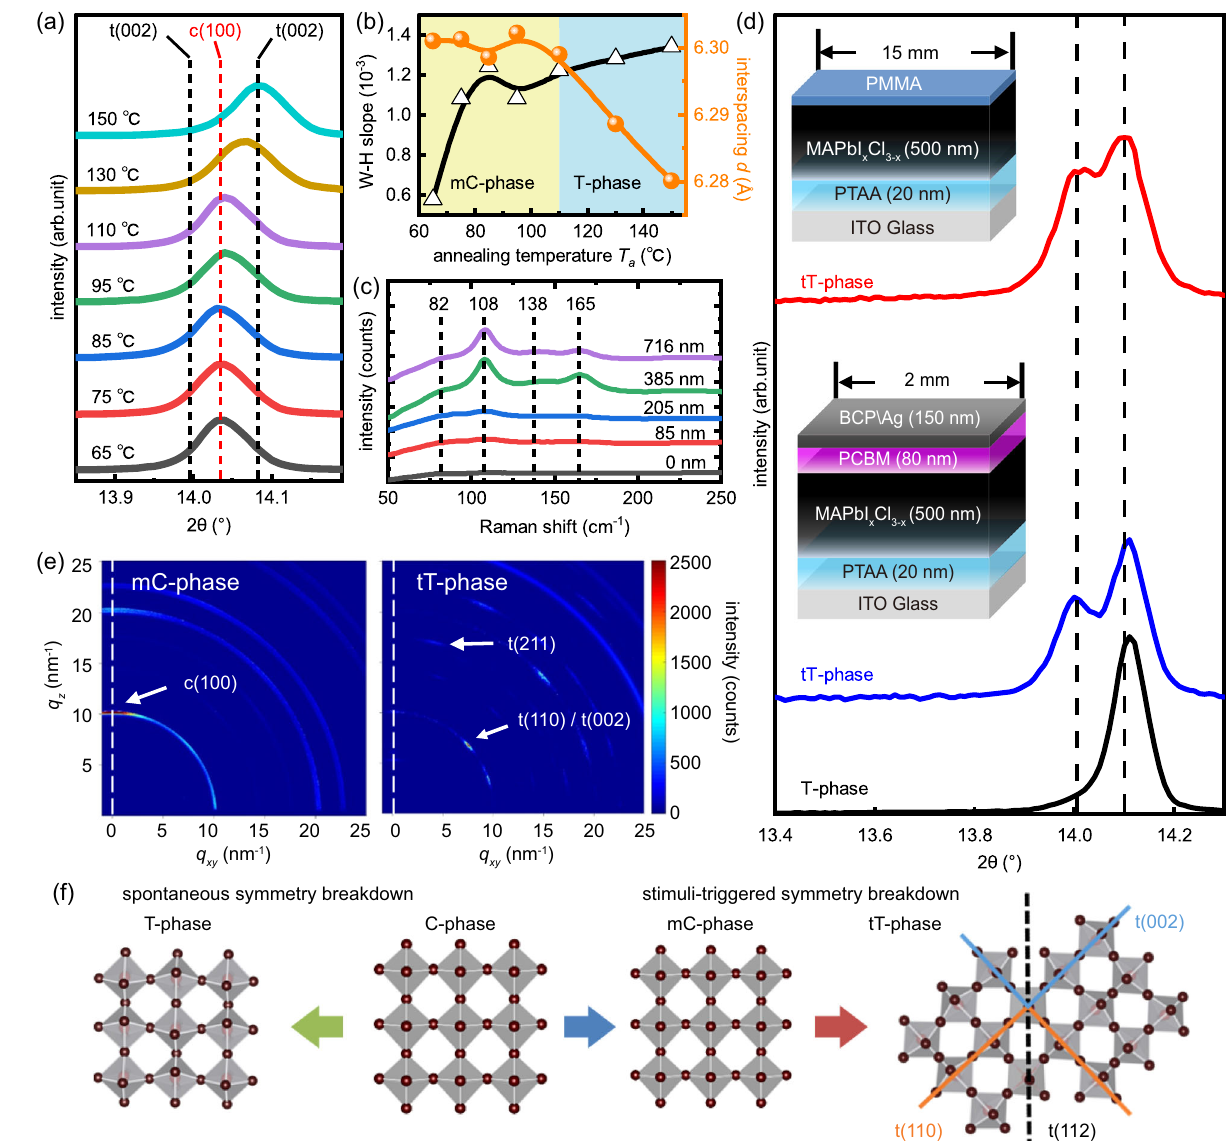
Fig. 1 | Formation mechanism of the tT-phase. a XRD patterns of MAPbI x Cl 3-x annealed atvarioustemperatures. b Interspacing (circle)and W – Hslope(triangle) versus annealing temperature (T a ) of MAPbI x Cl 3-x . c Raman spectra of PTAA/ MAPbI x Cl 3-x stack(0nm)and PTAA/MAPbI x Cl 3-x /PMMA stacks with various PMMA